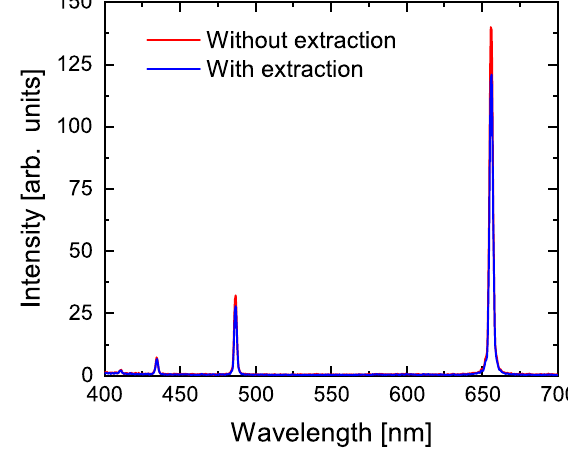
FIG. 8. Hydrogen spectrum obtained at 400 W without and with beam extraction (i.e., with the 75 kV voltage set on and off).